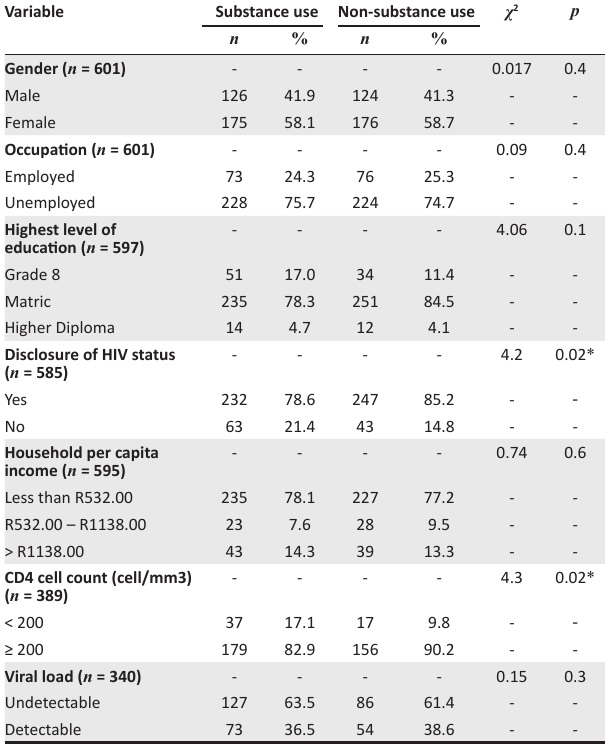
TABLE 1: The mean age and baseline CD4 count of the participants. Variable